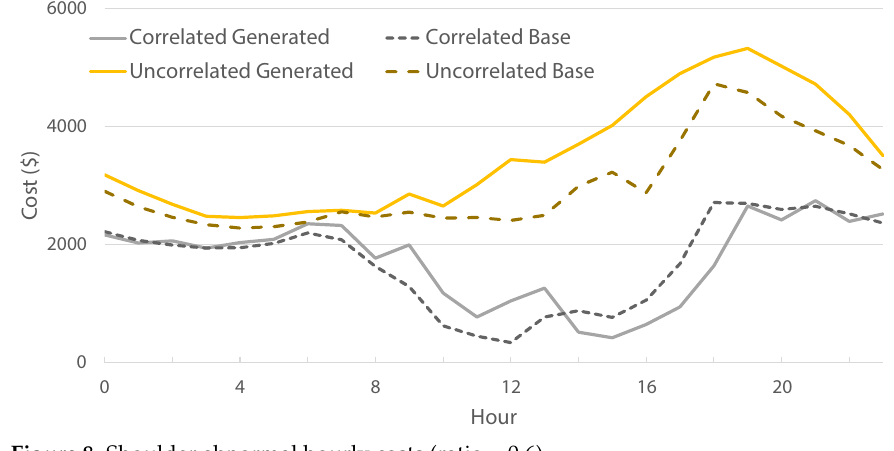
Figure 8. Shoulder abnormal hourly costs (ratio = 0.6).